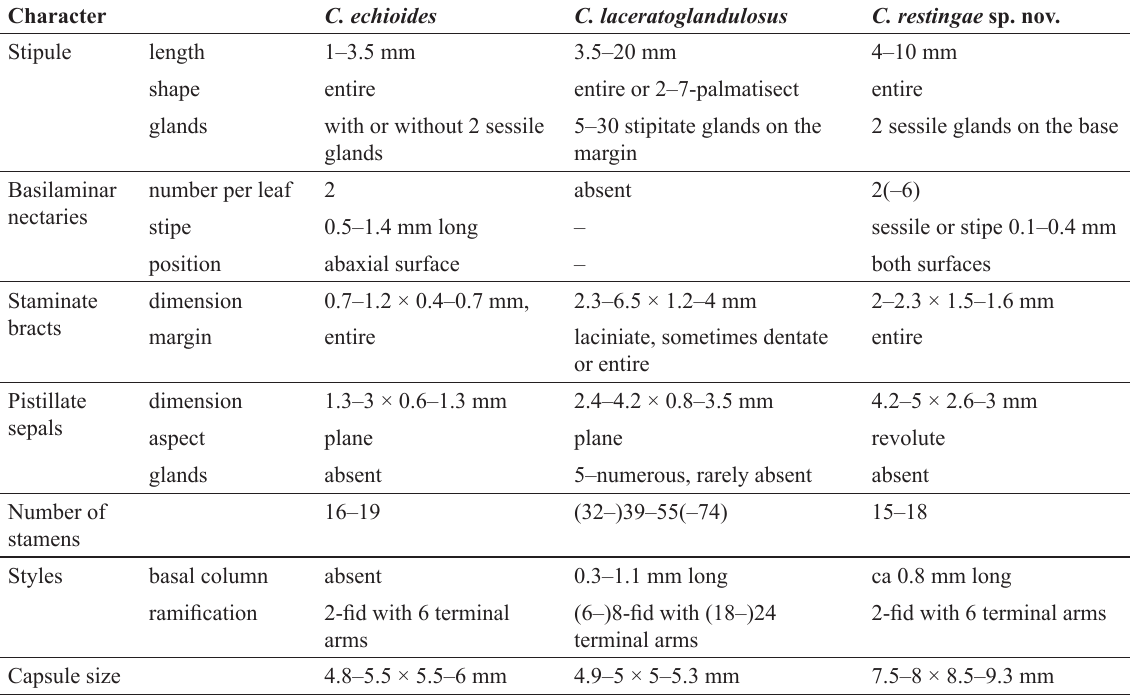
Table 2. Morphological comparison between C. restingae Sodré & Riina sp. nov., C. echioides Baill. and C. laceratoglandulosus Caruzo &